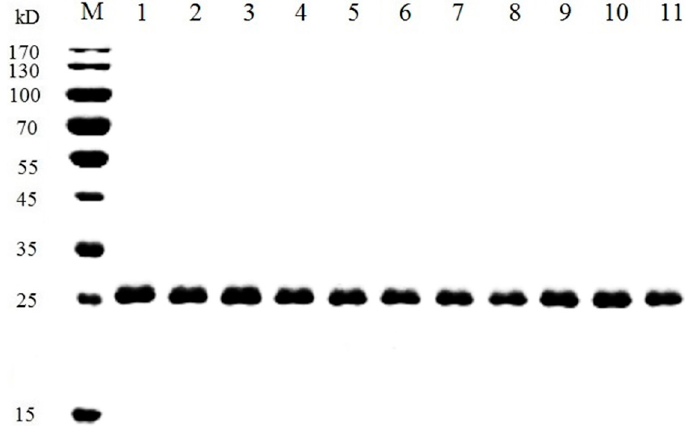
Figure 1. Results of protein purification. Lines 1-11 were the purification results of BlaR-CTD,A138E,Q147K,I188K,S190Y,V197D,S19C / G24C,R50C / Q147C,S76C / L96C,S135C / S145C,E183C / I188C protein; lane M was protein marker.